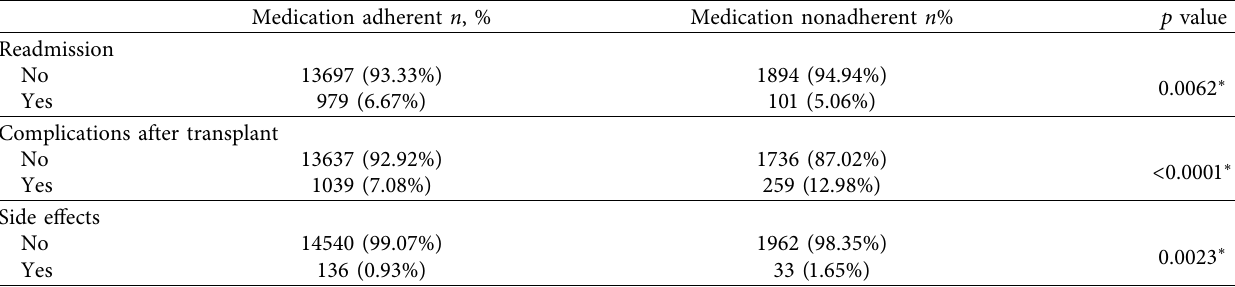
Table 2: Comparison of medication adherent and medication non-adherent patients on negative